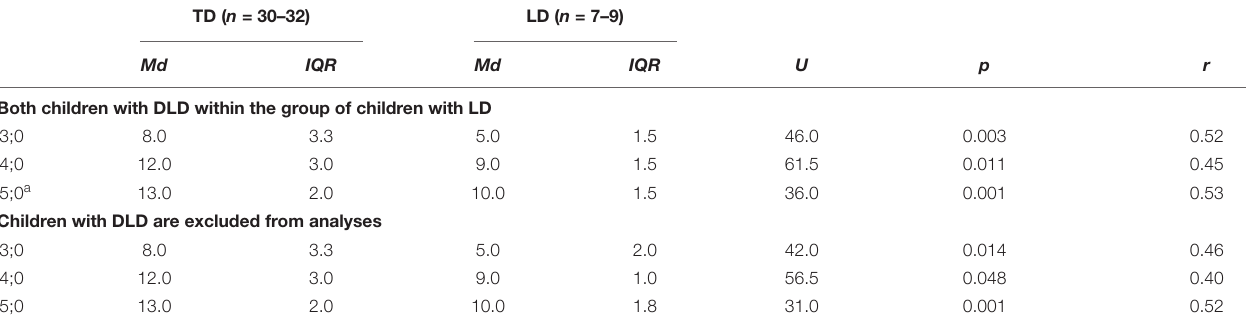
TABLE 6 | Comparison of iconic gesture comprehension of children with and without a history of LD. TD ( n = 30–32) LD ( n = 7–9) Md IQR Md IQR U p